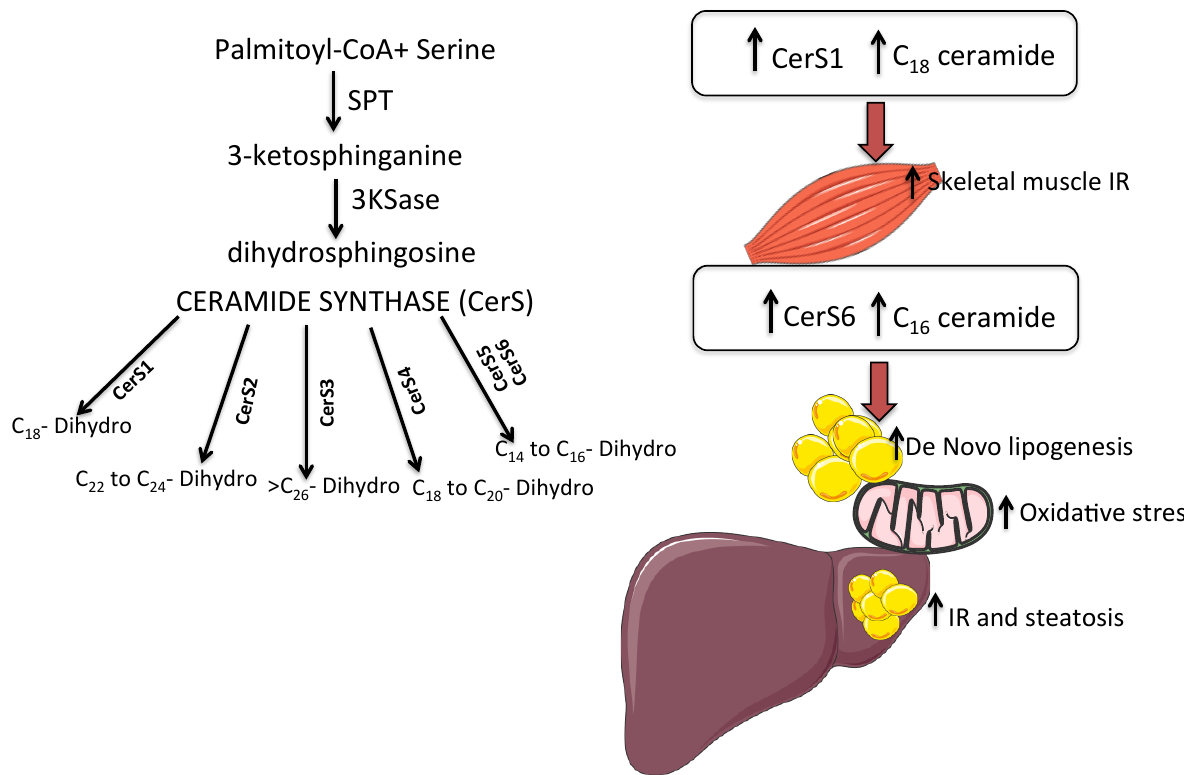
Figure 1. Ceramide synthases (CerSs) and the different isoforms (Cers1–6) are responsible for acylation reactions that produce different species of ceramides. In particular, CerS6 produces C16 ceramide that leads to insulin resistance (IR), de-novo lipogenesis and mitochondrial dysfunction. CerS1 mediated C18 ceramide that is related to skeletal muscle insulin resistance.